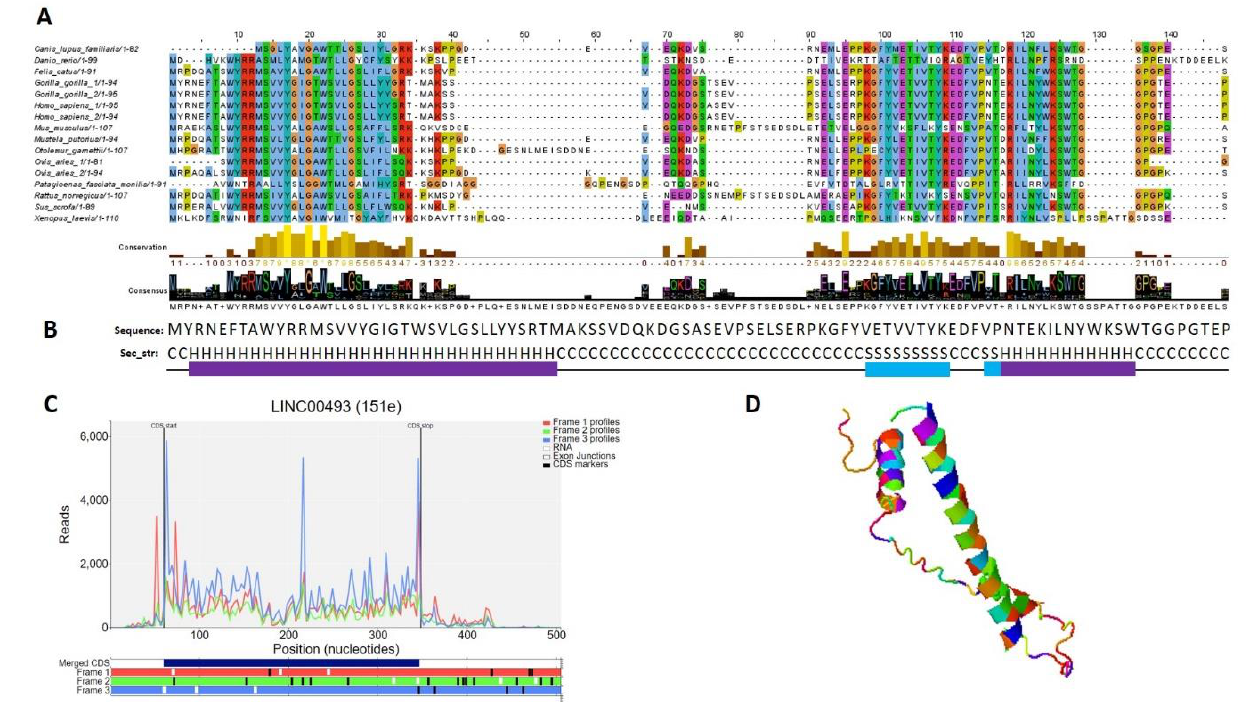
Figure 3. Analysis of the structure of the SMIM 26. ( A ) Multiple-species alignment of the amino acid sequences of the LINC00493 -encoded small protein SMIM26. ( B ) Predicted secondary structure (H: helix; S: strand; C: coil) of SMIM26. ( C ) Distribution of the RPF reads in the LINC00493 -ORF. ( D ) Predicted 3D structure of SMIM26.